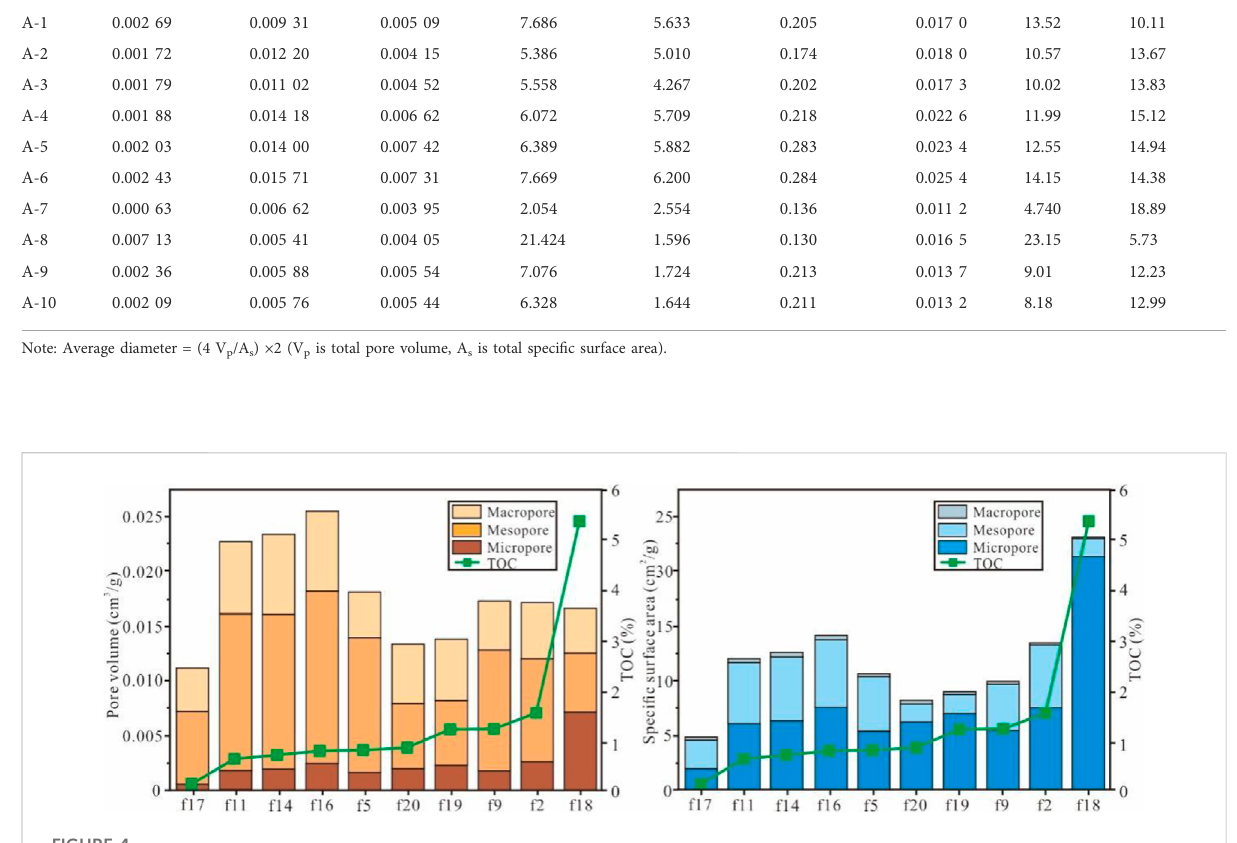
FIGURE 4 Distribution of pore volume and speci fi c surface area of pores of different sizes in shale